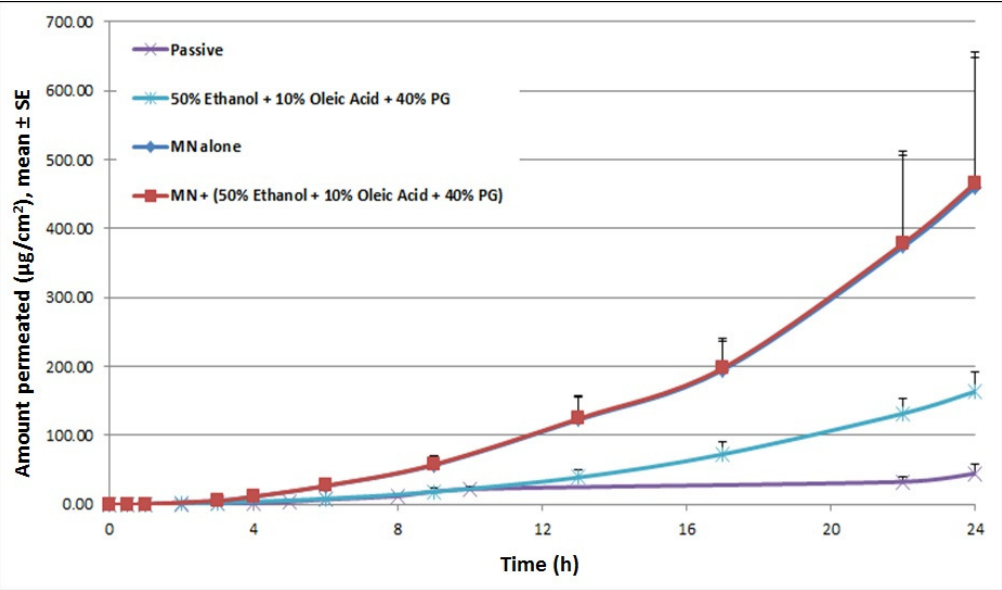
Figure 6. Microneedle mediated transdermal delivery of cyanocobalamin. Drug delivery increased significantly compared to the passive control. Combination with chemical enhancers did not result in a further increase in cyanocobalamin